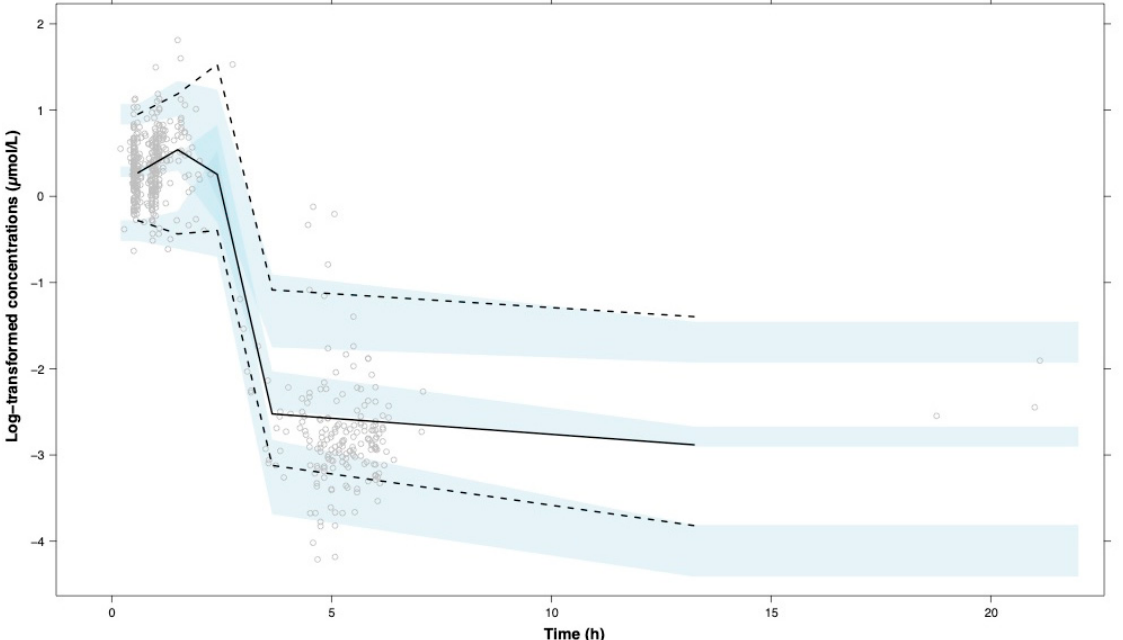
Figure 2. Visual predictive check plot of the BSA model using n = 1000 and log-transformed paclitaxel plasma concentrations. Dots represent observed paclitaxel concentrations, the black line represents the observed median concentrations, the dashed lines are the observed 5th and 95th percentiles, and the light blue areas represent the 95% confidence intervals of the median, 5th, and 95th